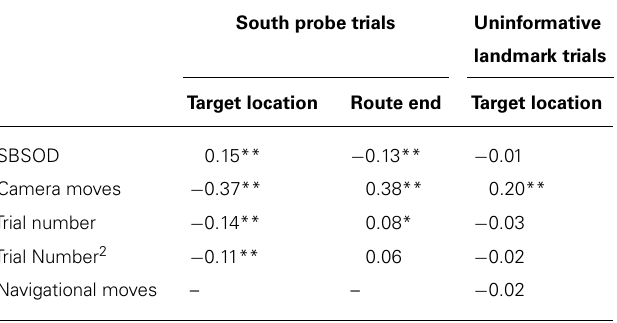
Table 2 | First-order correlations between predictor variables and performance outcomes on probe trials.